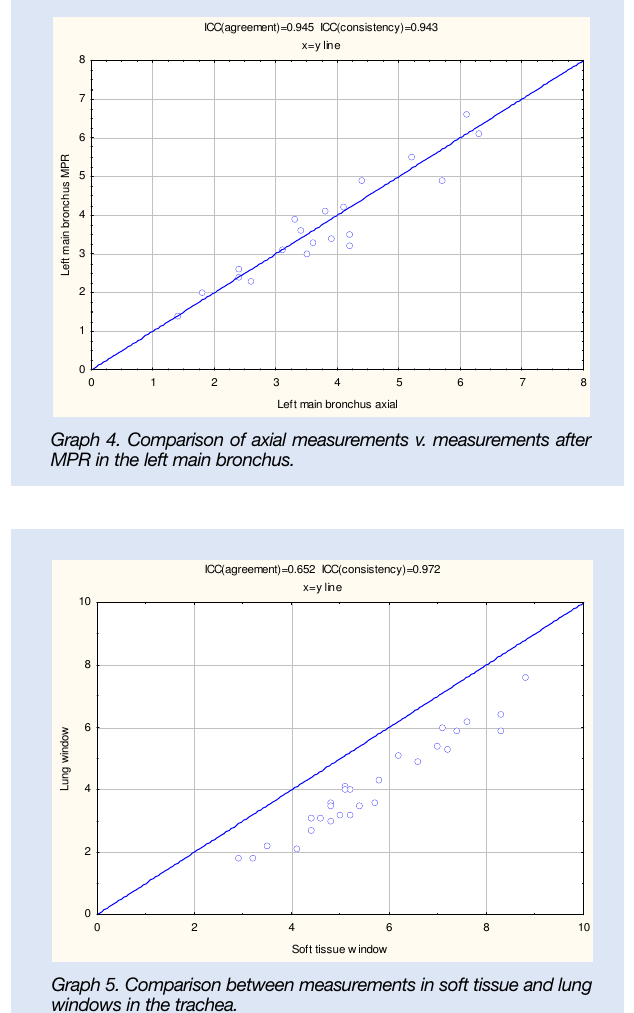
Graph 4. Comparison of axial measurements v. measurements after MPR in the left main bronchus  ICC(agreement)=0.945 ICC(consistency)=0.943 x=y line